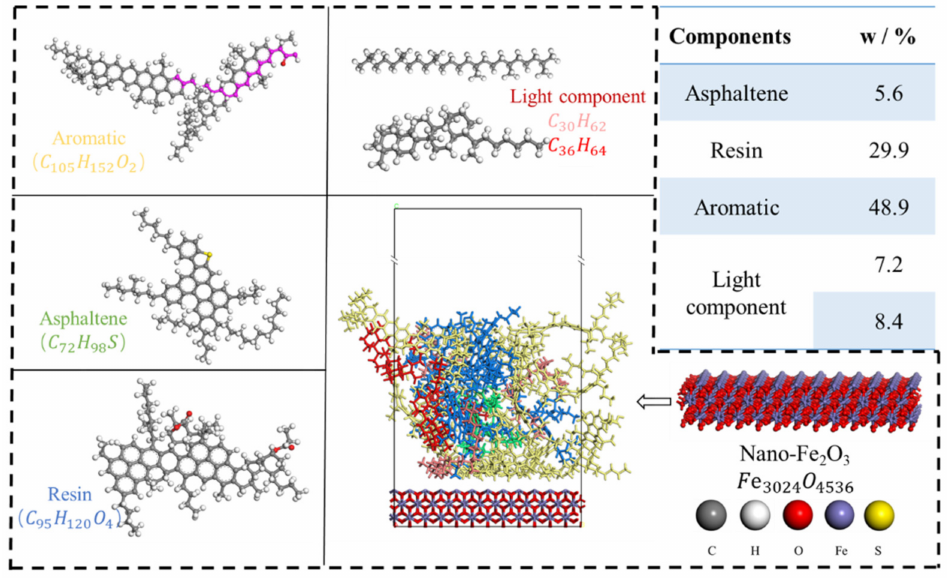
Figure 2. Structural model of asphalt SARA and Nano-Fe 2 O 3